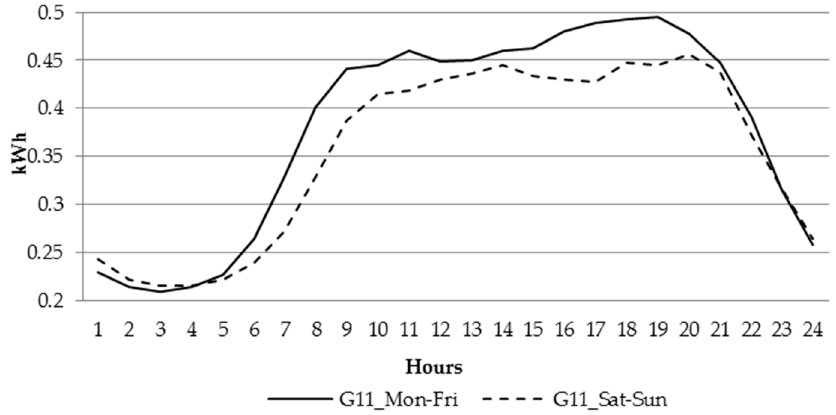
Figure 6. Working and weekend days average load profiles of the entities matching G11 characteristics.